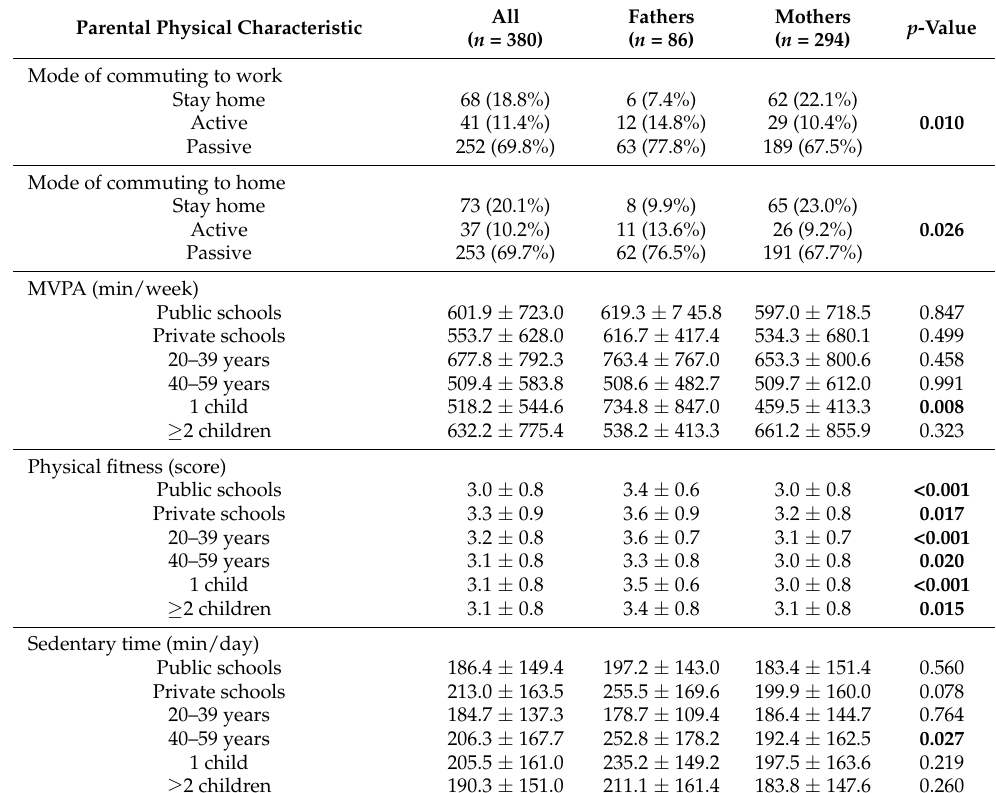
All Fathers Mothers p -Value ( n = 380) ( n = 86) ( n = 294)